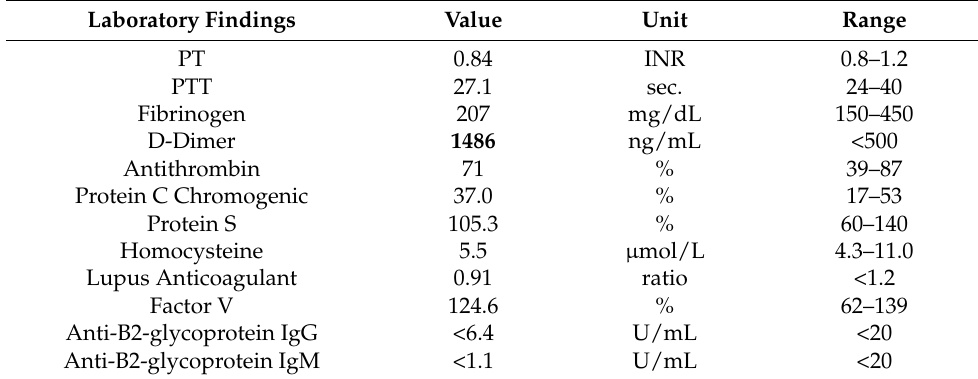
Table 2. Laboratory findings of the neonate at birth.